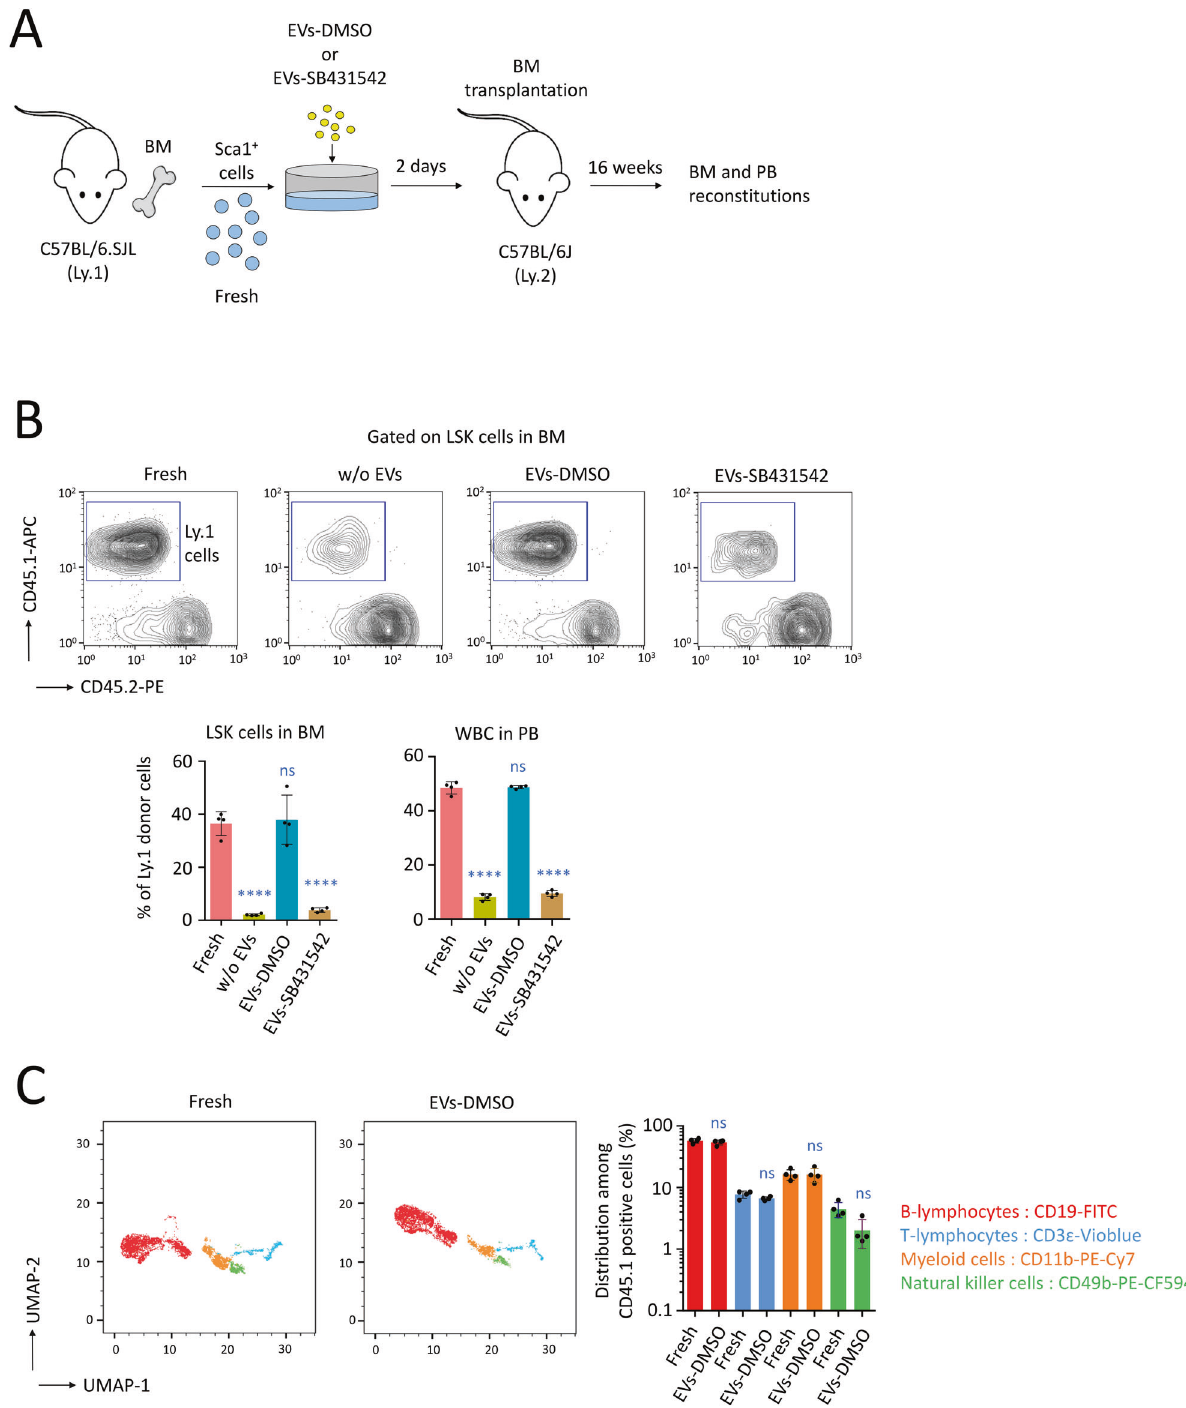
Fig. 6 Transplantation of HSC, maintained ex vivo with MS-5-EVs carrying p-Smad2. A Procedure followed to maintain Sca1 + HSC ex vivo for 48 h with EVs-DMSO or EVs-SB431542. B Analysis of the reconstitution capacity in vivo following the i.v. transplantation of 4 × 10 5 Sca1 + cells in C57BL/6J (Ly.2) recipients, n = 4 mice per group. Sca1 + cells isolated from donor C57BL/6SJL (Ly.1) mice were freshly injected (fresh) or exposed to EVs ex vivo for 48 h before the transplantation. We assessed the reconstitution 16 weeks after the transplantation on LSK cells in BM, as well as on WBC in PB. Examples of cytometry plots for LSK cells, statistics on LSK cells, and WBC. Data are shown as means ± SD, n = 4 mice. P value calculated against the fresh condition and measured by one-way ANOVA with Tukey ’ s multiple comparison test; **** P < 0.0001; ns, non-signi fi cant. C UMAP data frame showing distribution among CD45.1 positive WBC in different hematological lineages (B-lymphocytes, T-lymphocytes, myeloid cells, and natural killer cells). Data showing that Sca1 + cells treated ex vivo with EVs-DMSO for 48 h were able to reconstitute hematopoiesis in all lineages in secondary recipient mice, and to a level that was similar to fresh Sca1 + cells. Data are shown as means ± SD, n = 4 mice. P value measured by two-tailed unpaired Student ’ s t test; ns, non-signi fi cant.